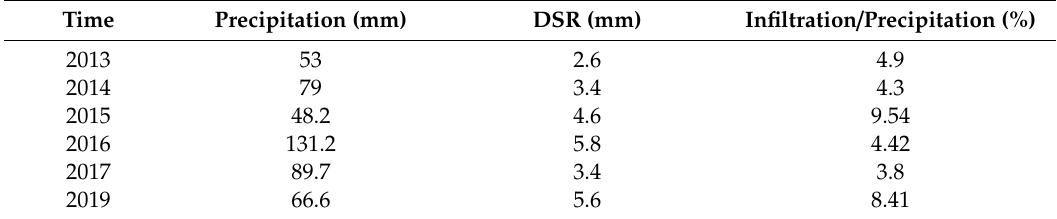
Table 1. Changes in precipitation and deep soil recharge (DSR) from 2013 to 2019.